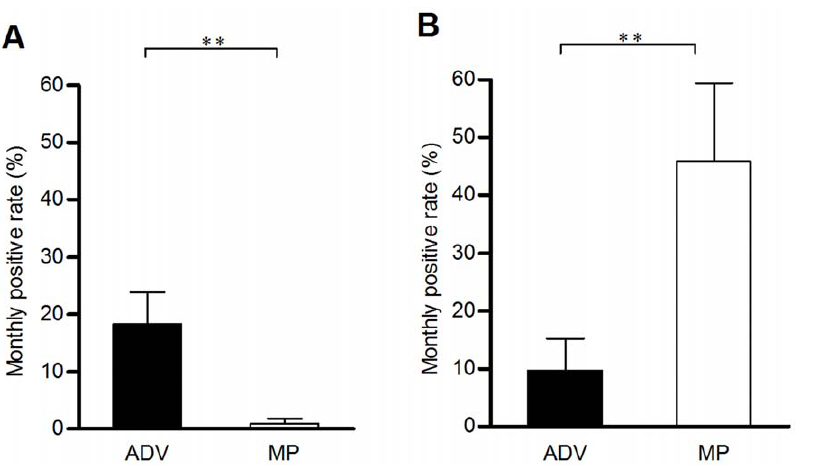
Figure 1. Airborne adenovirus and Mycoplasmapneumoniae in the pediatric public areas. The monthly positive rates (mean 6 se) of airborne particles containing adenovirus (ADV) and Mycoplasma pneumoniae (MP) in the pediatric emergency room (ER) (A) and pediatric outpatient department (OPD) (B). **: p , 0.01.